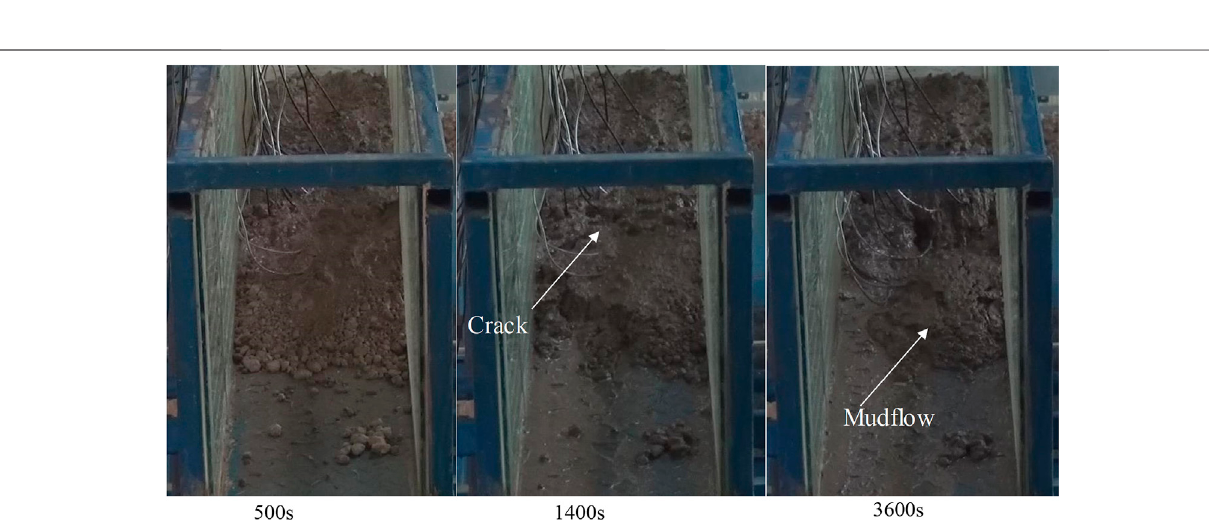
FIGURE 8 | Distribution of the domains that exhibit a preferred slope failure mode. (A) De fi nition of the seepage vector magnitude and direction; (B) The tests ’ failure mode.